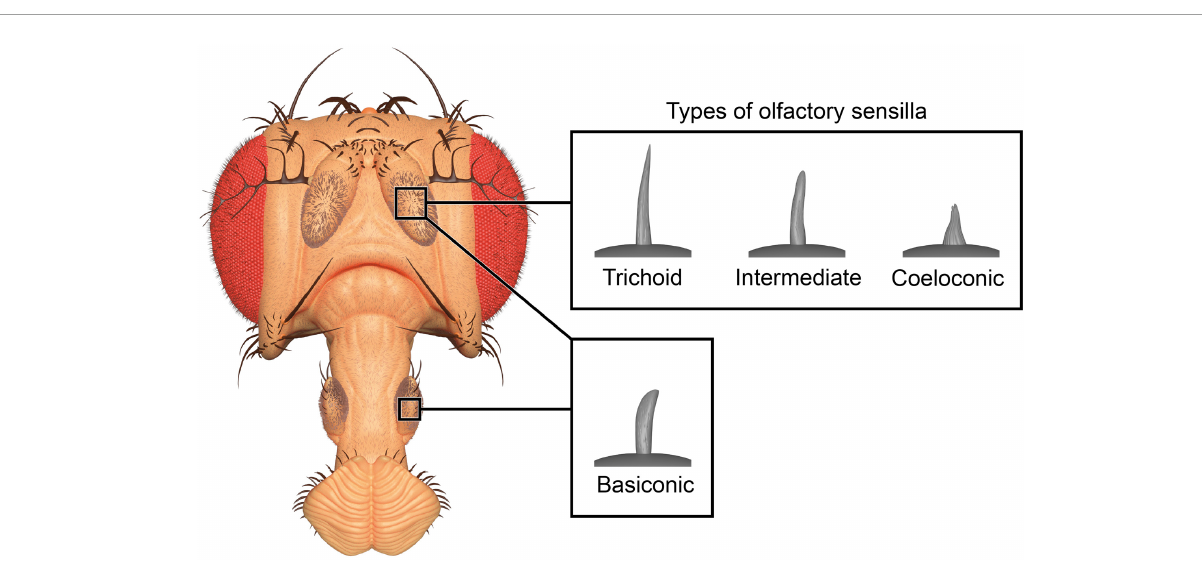
FIGURE2 Three-dimensional render of olfactory sensilla types. Club-shaped basiconic sensilla are found on antennae and maxillary palps, while hair-like trichoid, cone-shaped coeloconic, and intermediate sensilla are only found on the antennae. The 3D model of the head is based on photographs and the models of sensilla are based on published micrographs (de Bruyne et al., 2001; Yao et al.,